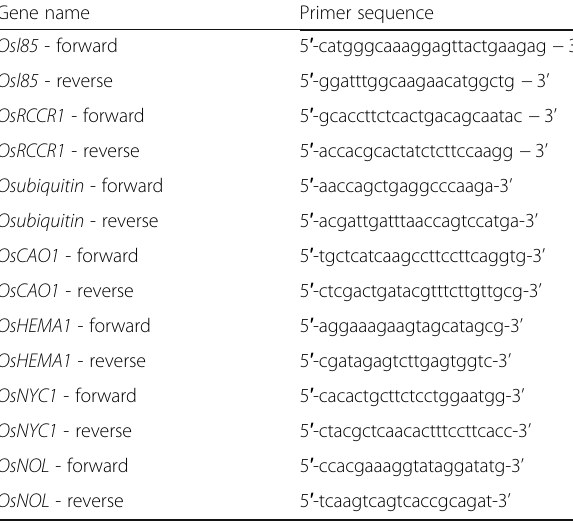
Table 1 Primers used for quantitative RT-PCR